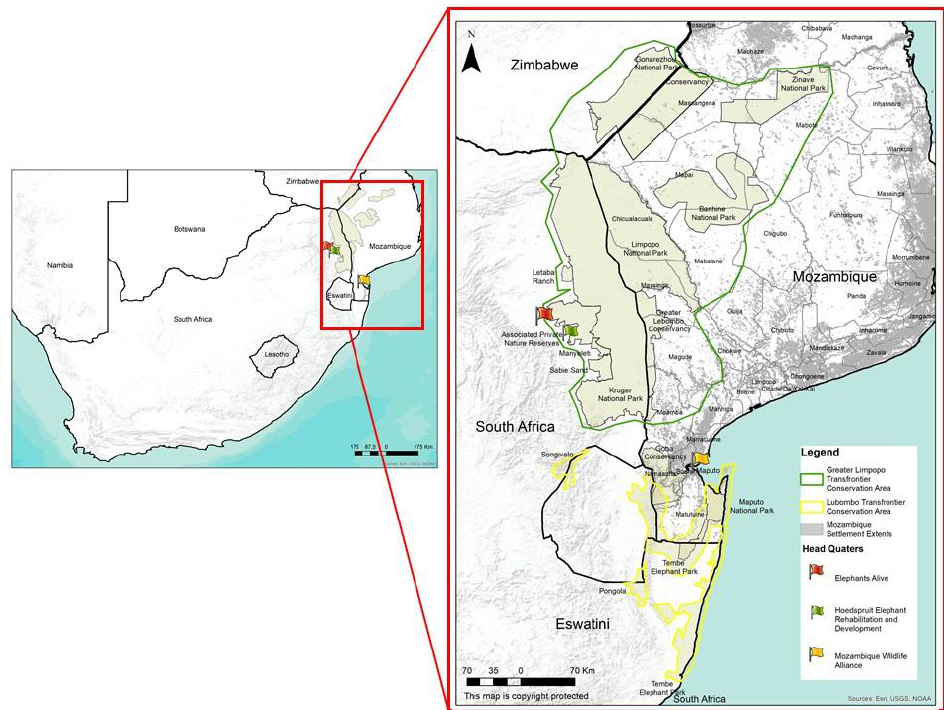
Figure 1. Maps showing the location of the main headquarters in South Africa and Mozambique. The red square depicts the study site as defined by the elephants’ movements. The enlarged map shows a more detailed representation of the protected areas and Mozambican districts within the study site. The headquarters of the three collaborating entities are shown, with Elephants Alive (red flag) and Hoedspruit Elephant Rehabilitation and Development (green flag) based in South Africa while the Mozambique Wildlife Alliance (yellow flag) is based in Mozambique. The various protected areas that form part of two Transfrontier Conservation Areas (TFCAs) are outlined in green for Great Limpopo Transfrontier Conservation Area and yellow for Lubombo Transfrontier Conservation